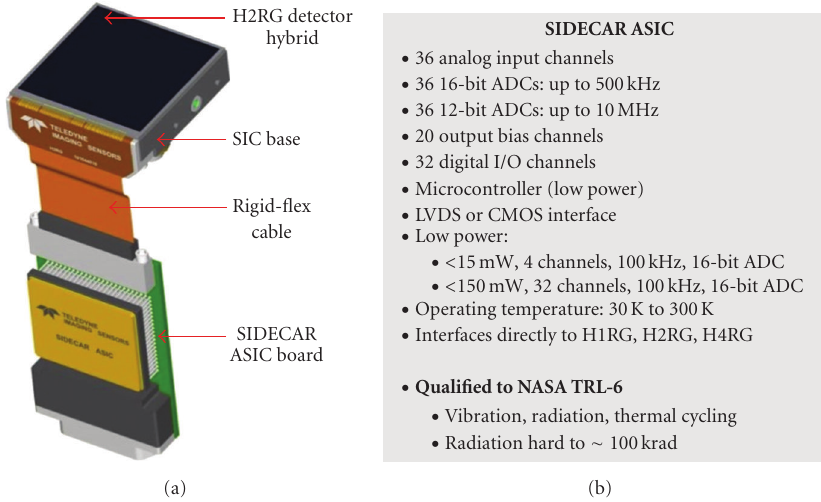
Figure 15: The new H2RG-SIDECAR cryogenic packaging and the main characteristics of the SIDECAR